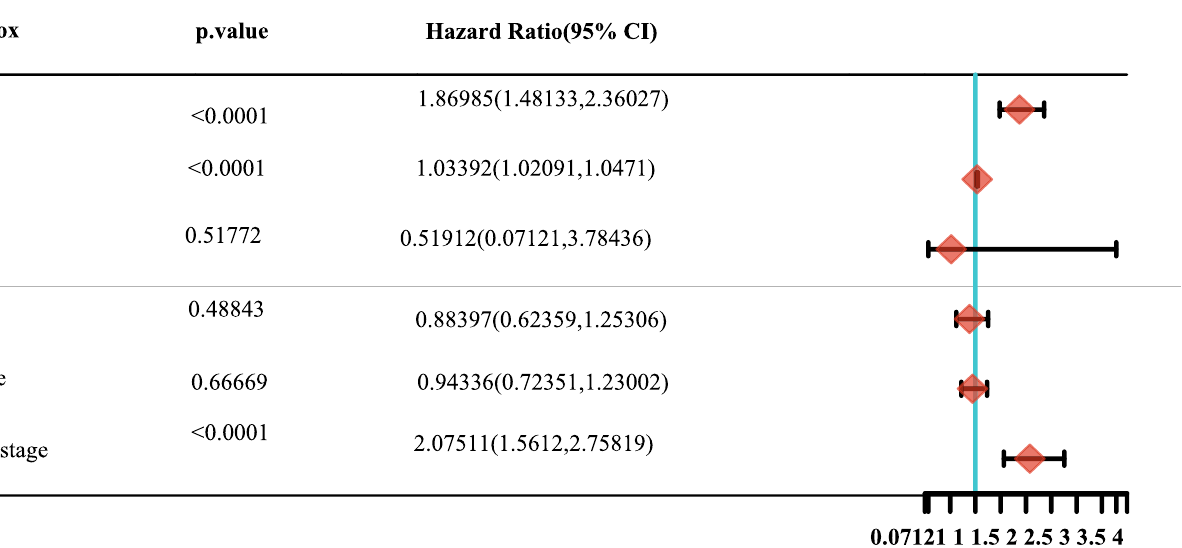
Frontiers in Molecular Biosciences |